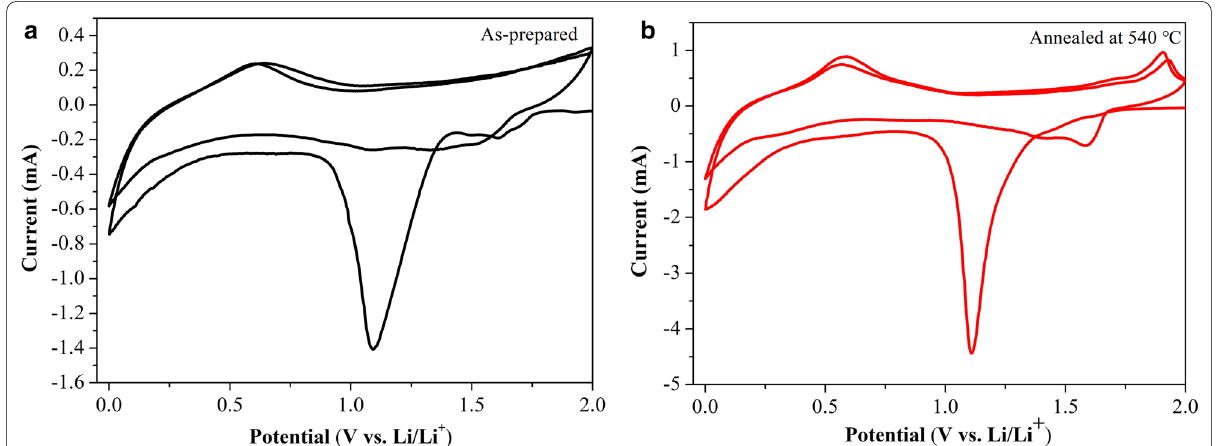
Fig. 5 CV plots of initial two cycles scanned between 0 and 2 V at a rate of 0.1 mV s –1 : a as-prepared and b annealed at 540 °C